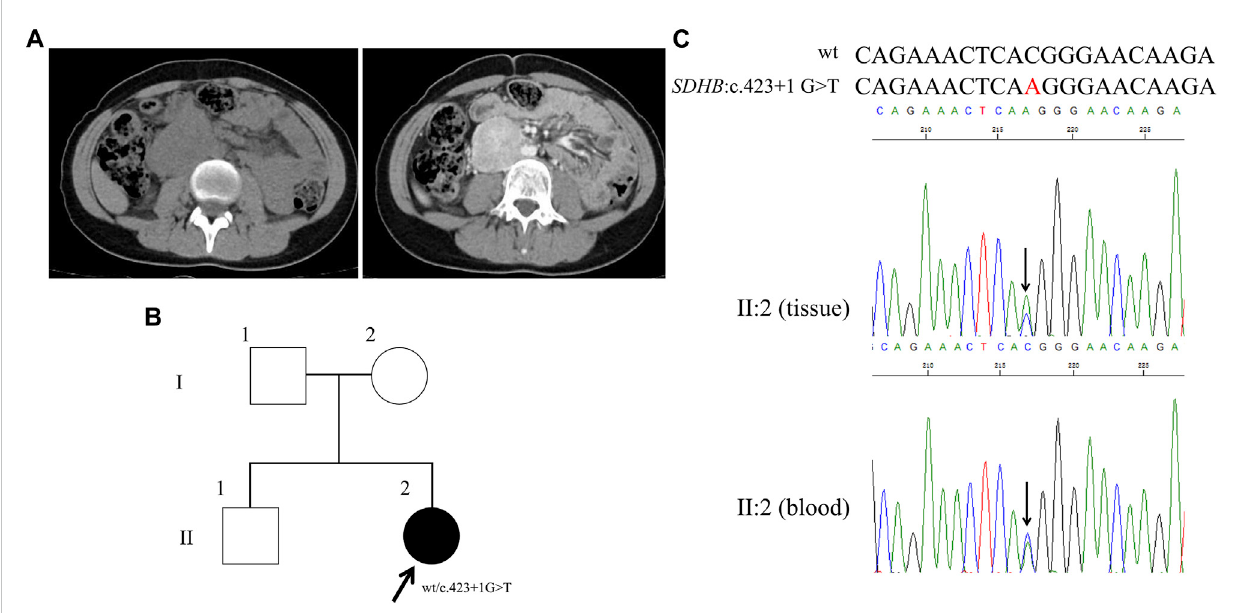
FIGURE 4 Clinical and genetic characteristics of Proband 4. (A) CT (left) and contrast-enhanced CT scan (right) imaging in a 17-year-old female patient with PPGL showing a right retroperitoneal occupancy. (B) Pedigree of the Proband 4 (adopted by the family) family with PPGL. Squares and circles indicate males and females, respectively; Roman numerals indicate generations; and Arabic numerals indicate individual family members. Each member ’ s SDHB genotype are shown below the squares and circles. Wt, wild type. (C) DNA sequencing data of the Proband 4 (II:2, tissue, and blood) with